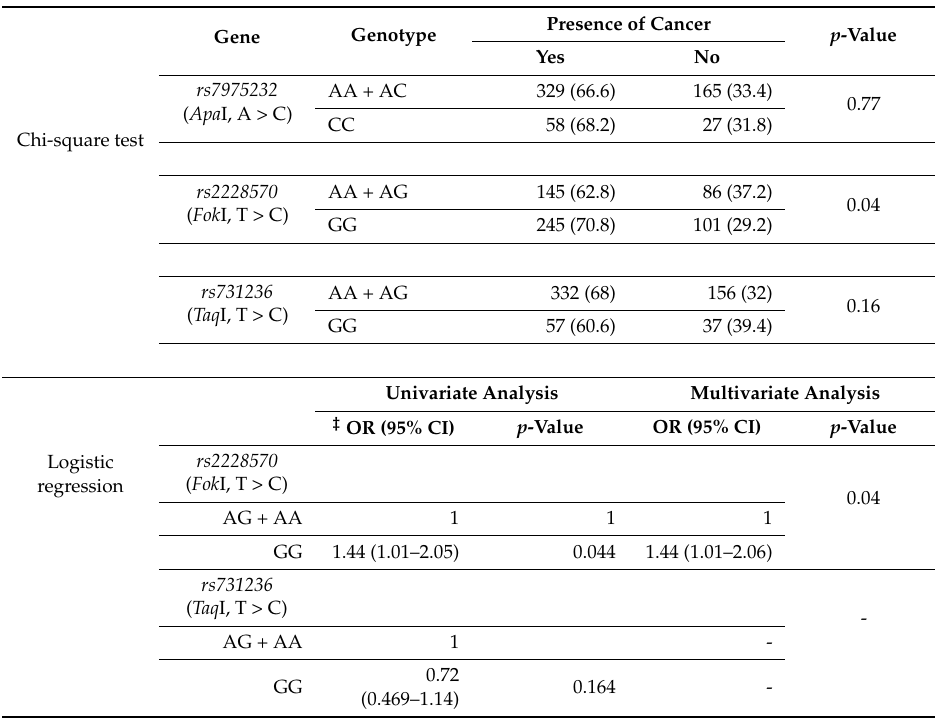
Table 3. Association of VDR polymorphisms and breast cancer